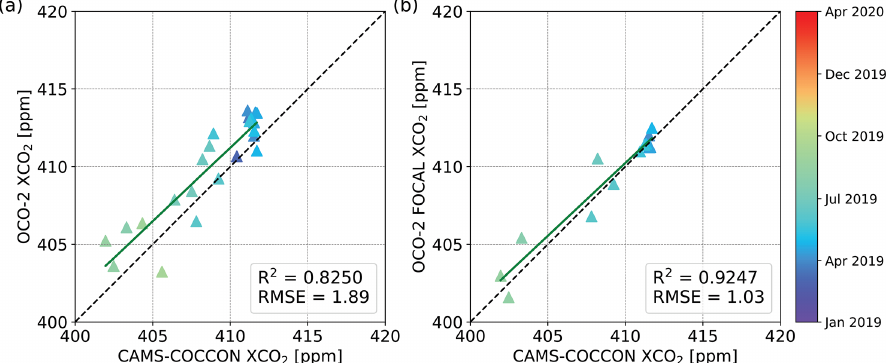
Figure 16. Correlation plots of (a) OCO-2 and (b) OCO-2 FOCAL with respect to CAMS-COCCON XCO 2 at Peterhof. All satellite data were adjusted for the CAMS a priori profile.